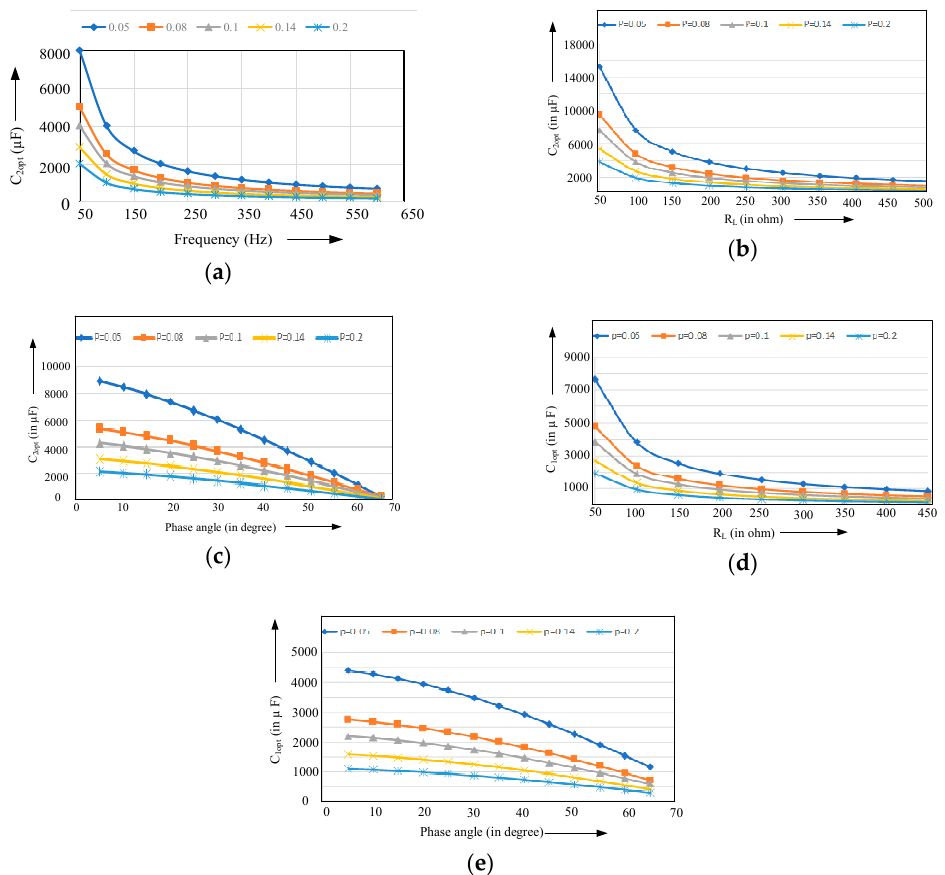
Figure 5. Variation in optimal capacitance C 2opt with ( a ) frequency ( f ), ( b ) load resistance (R L ), ( c ) and phase angle for different values of ripple in capacitor voltage and variation in optimal capacitance C 1opt with ( d ) load resistance (R L ) and ( e ) phase angle for different values of ripple in a capacitor